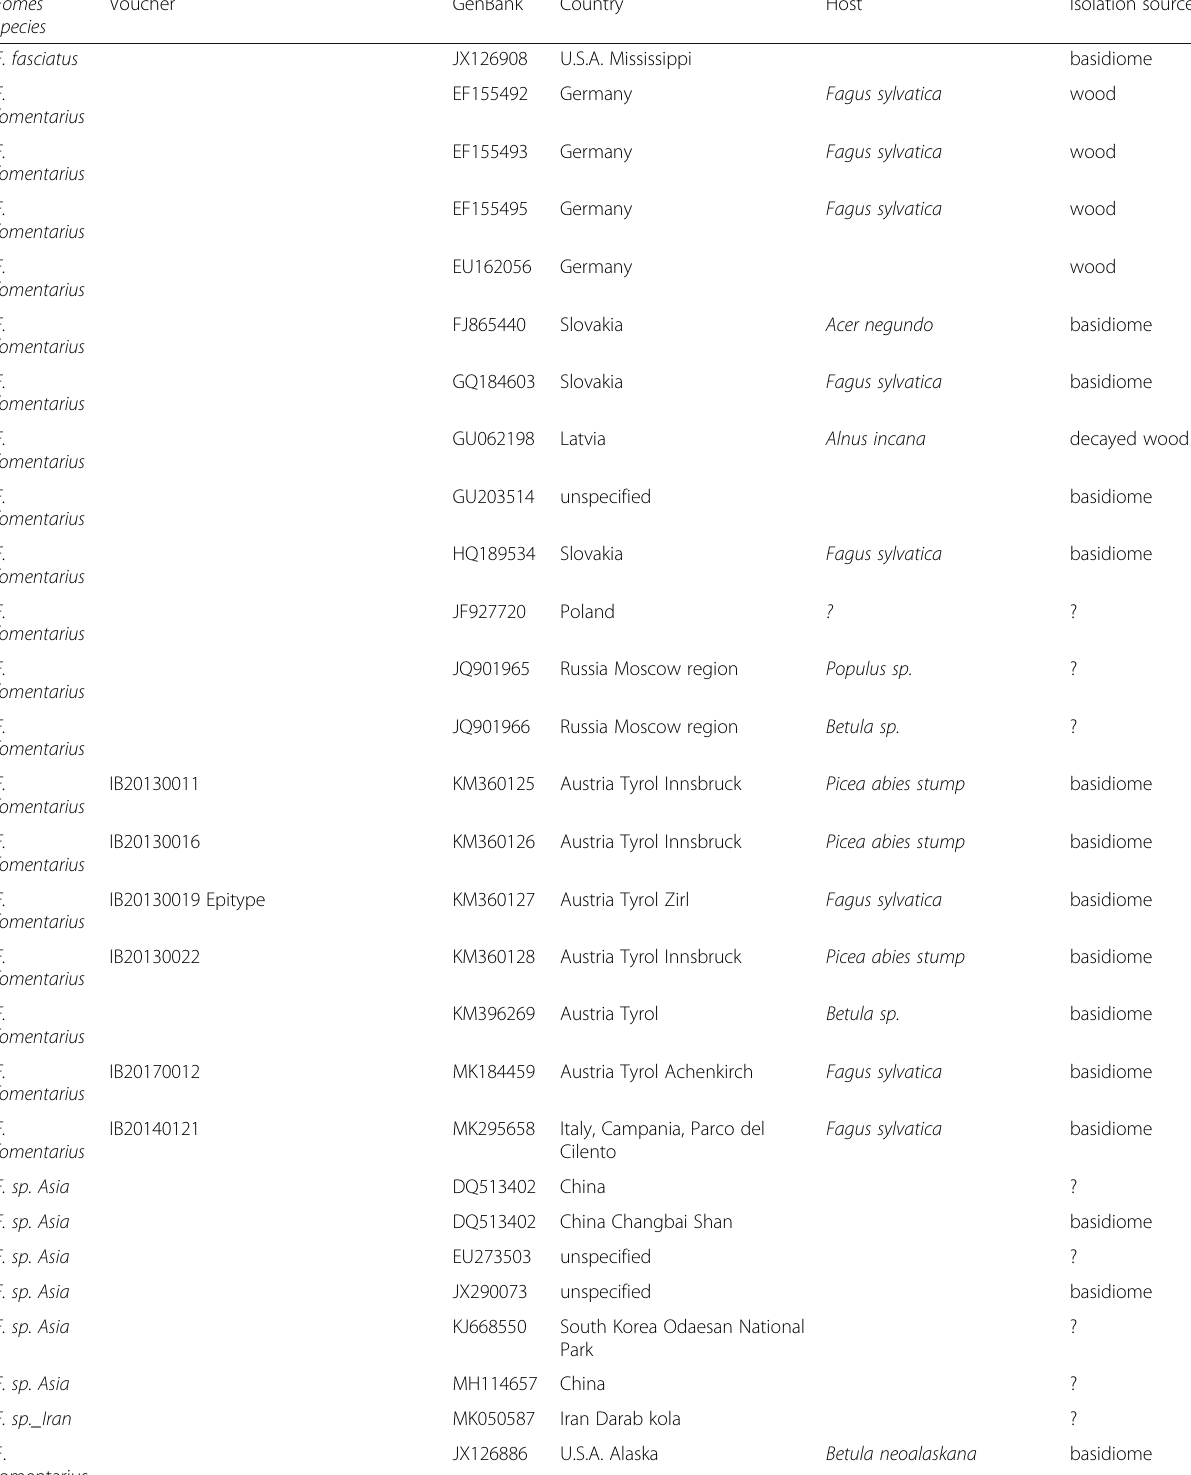
Table 1 Fomes sequences included in the phylogenetic analysis with information on the species identification, the newly sequenced voucher, the GenBank Accession number, and available information on geographic provenance as well as on host plant and isolation source. Sorted based on GenBank Accession number within clades